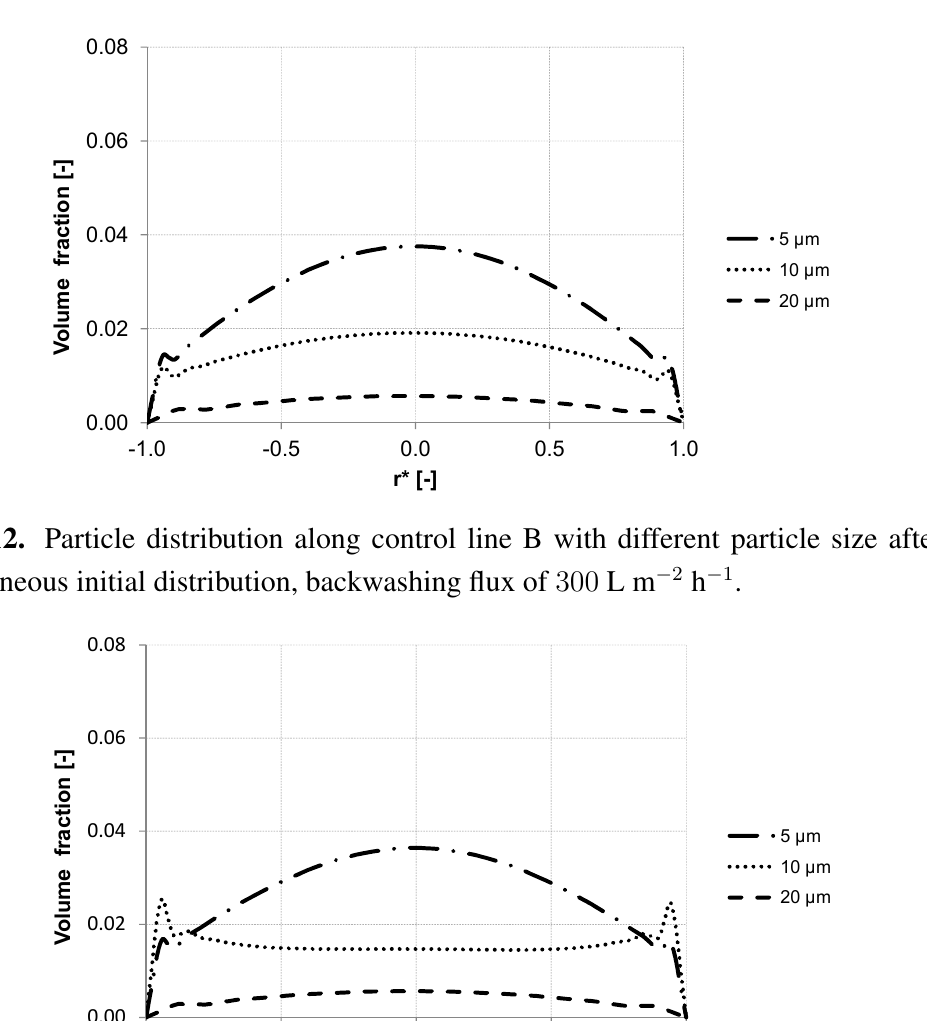
Figure 11. Particle distribution along control line A with different particle size after 5 s (homogeneous initial distribution, backwashing flux of 300 L m − 2 h − 1 .